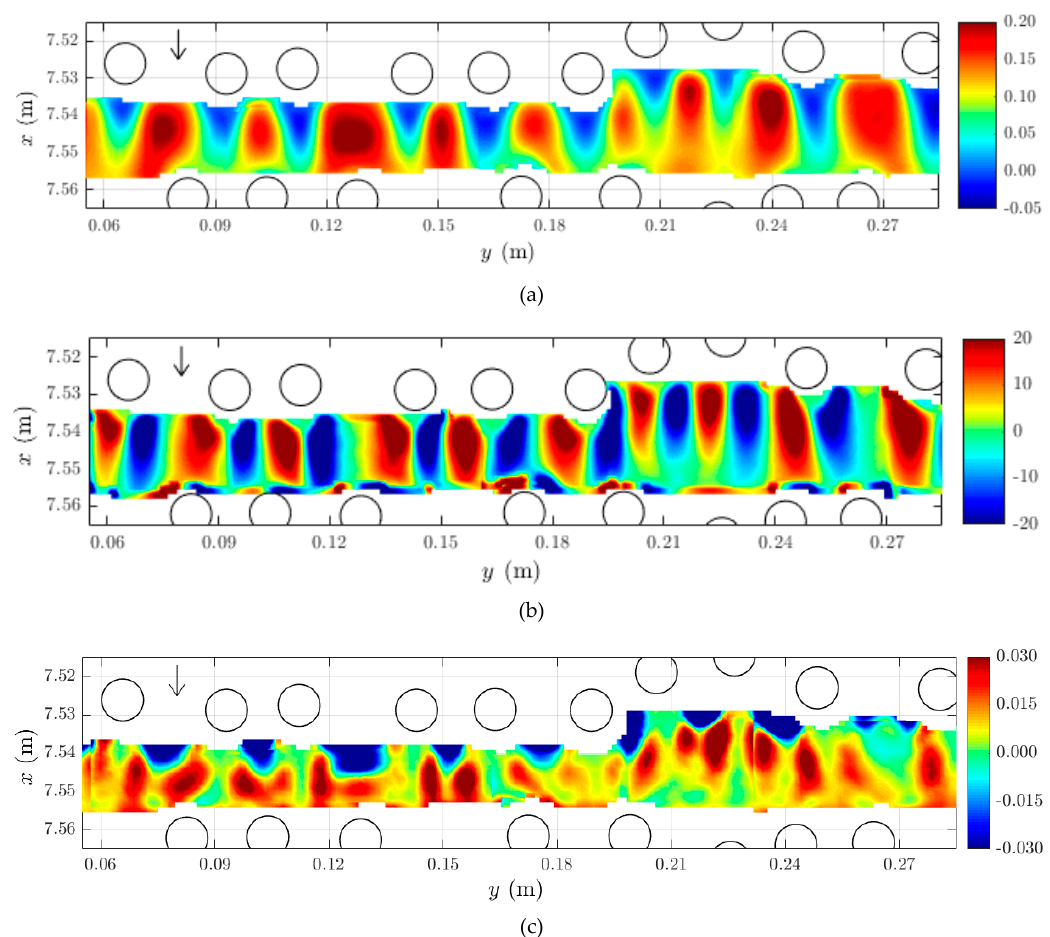
Figure 4. ( a ) Time-averaged longitudinal velocity map (m/s); ( b ) out-of-plane vorticity map (m − 1 ); ( c ) rate of production of TKE (m 2 s − 3 ), at longitudinal position P8 and at 3.1 cm above the bed corresponding to 60% of the flow depth. (Source: Ricardo et al., 2014).